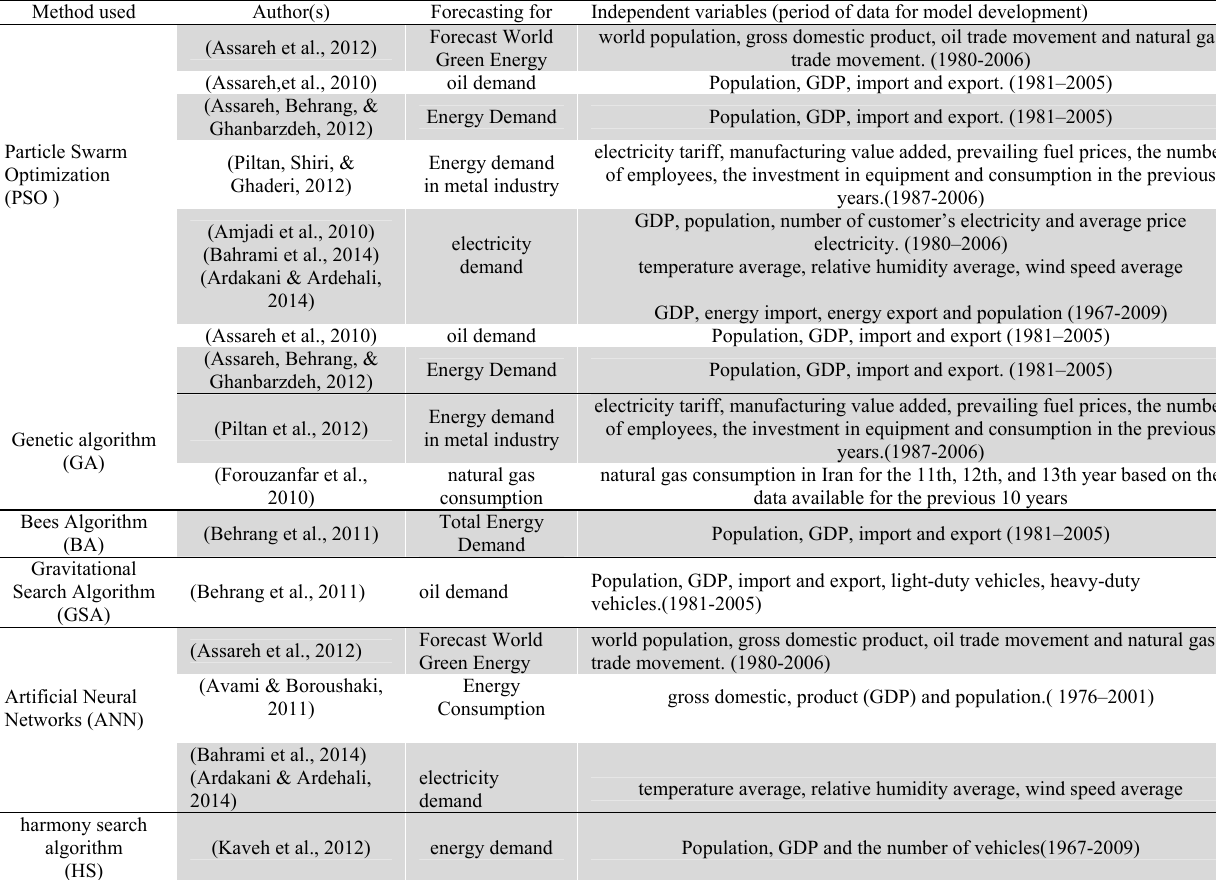
Summary of Iranian energy demand estimation